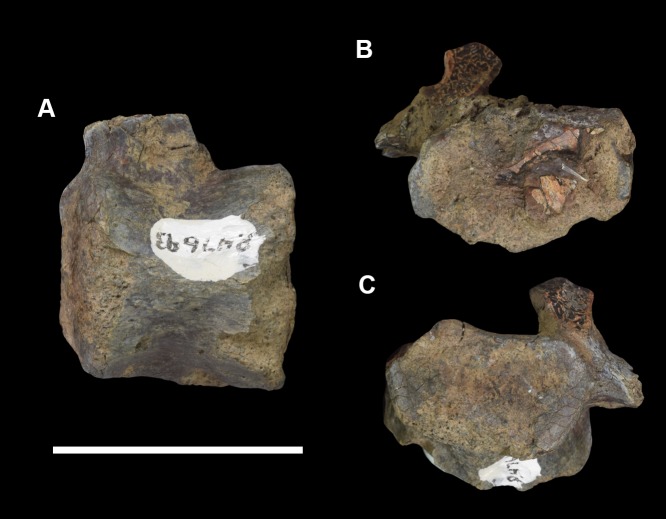
Lumbar vertebra of Periptychus carinidens (NMMNH P-47693).(A) dorsal view; (B) anterior view; (C) posterior view. Scale bar: 30mm.